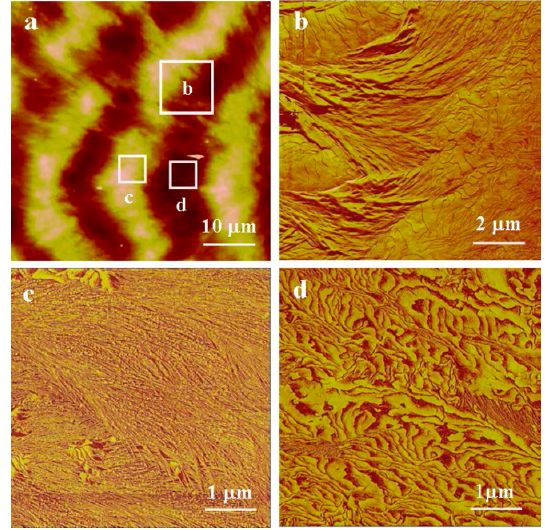
Figure 1. Atomic force microscopy (AFM) images of the blend of poly(vinyl chloride) (PVC) and poly( ε -caprolactone) (PCL) grown at 45 °C [41]. ( a ) A height image showing several bands of a spherulite and boxes b, c and d mark areas enlarged in Figure 1b–d, respectively; ( b ) a phase image showing the interface between a ridge and a valley at which edge-on and flat-on lamellae are interwoven together; ( c , d ) phase images showing the morphologies of the ridges and valleys containing the edge-on and flat-on lamellae, respectively.